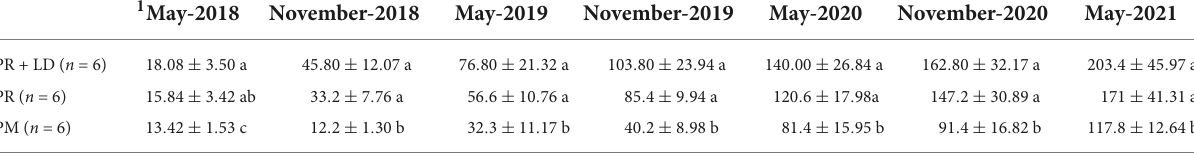
TABLE 2 Average plant height (cm) of trees in the Xifeng plantation every 6